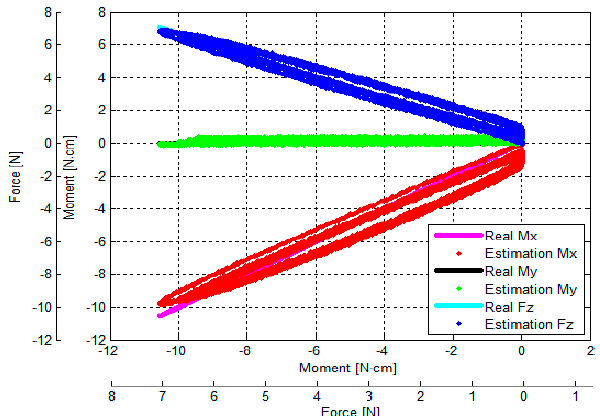
Figure 17. Comparison between real ( F z , M x ) and estimated ( F z , M x ): external force was applied to and released from point ② obtained by the sensor calibration device as shown in Figure 12.